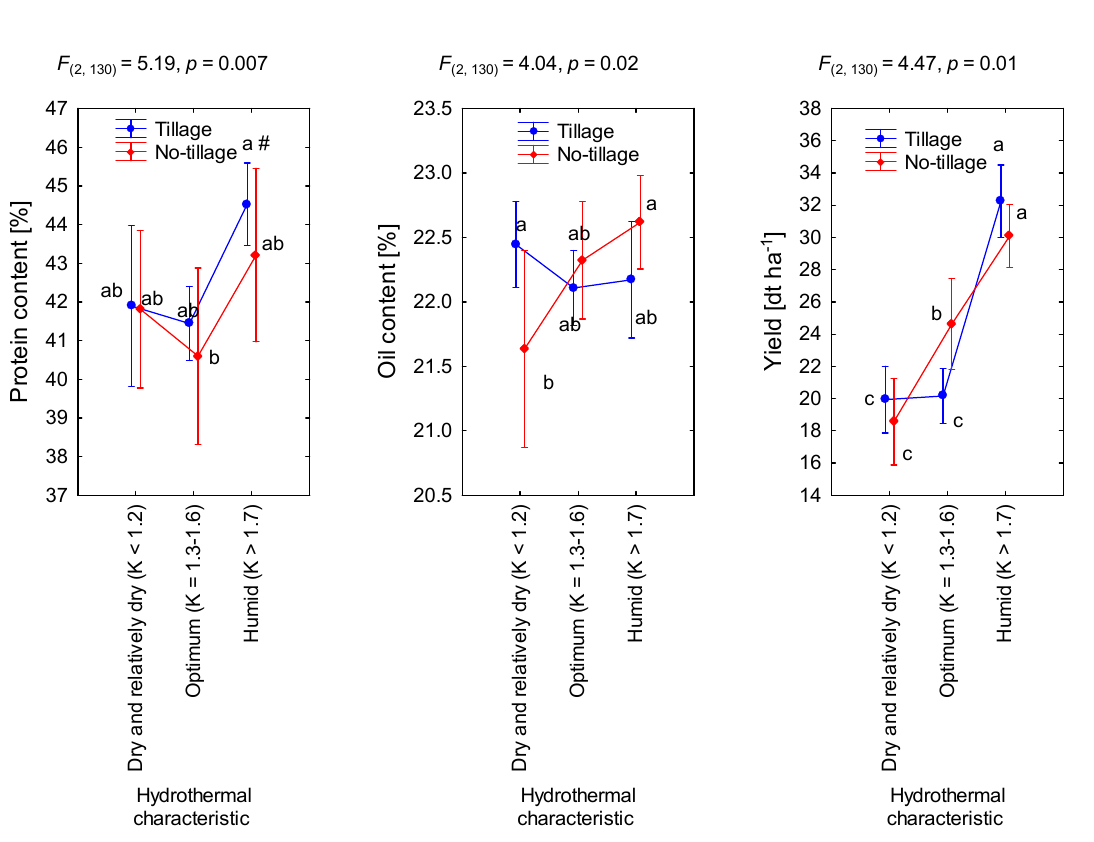
Figure 6. The effect of tillage/no-tillage system and hydrothermal conditions on soybean. Means ± confidence intervals ( p = 0.95) of years and cultivars studied in 2018–2020 in Central Poland. # Various letters indicate the heterogenous groups according to the HSD Tukey’s test at p = 0.05.